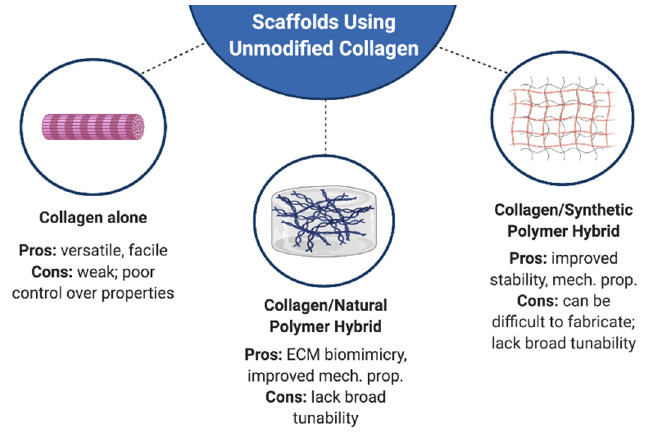
Figure 1. Overview of common approaches to make tailored scaffolds using unmodified collagen I. Figure created using BioRender.com.